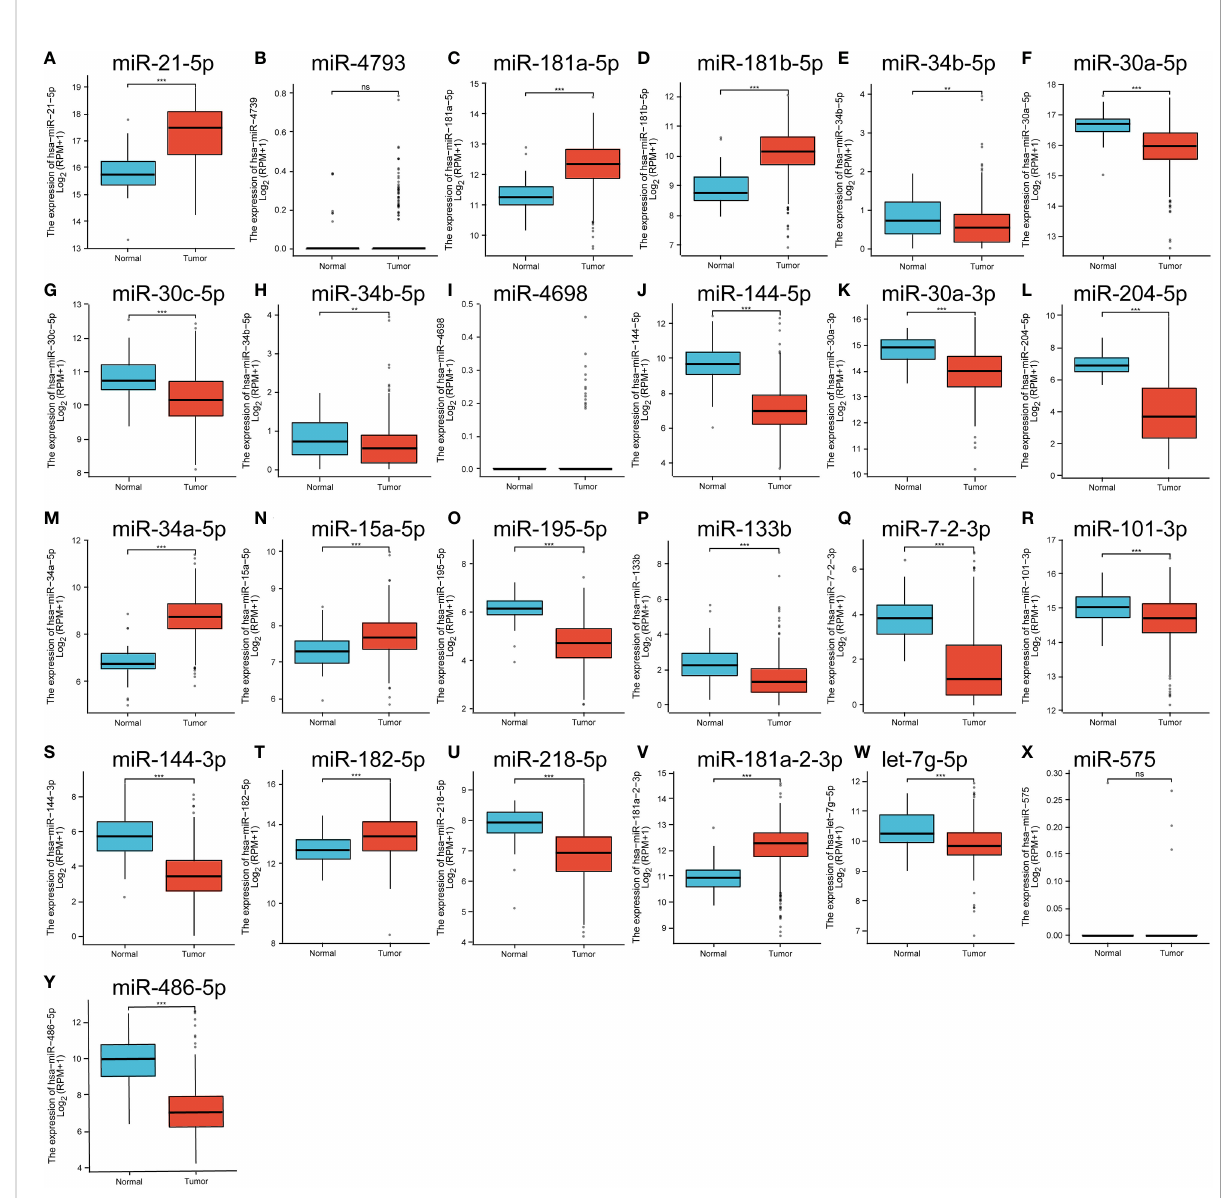
FIGURE 4 (A – Y) is the expression of signi fi cantly different miRNAs in the GEO database that have a targeted binding relationship with the prognostic factors in the TCGA database. ns means no statistical signi fi cance, ** means p<0.01, *** means